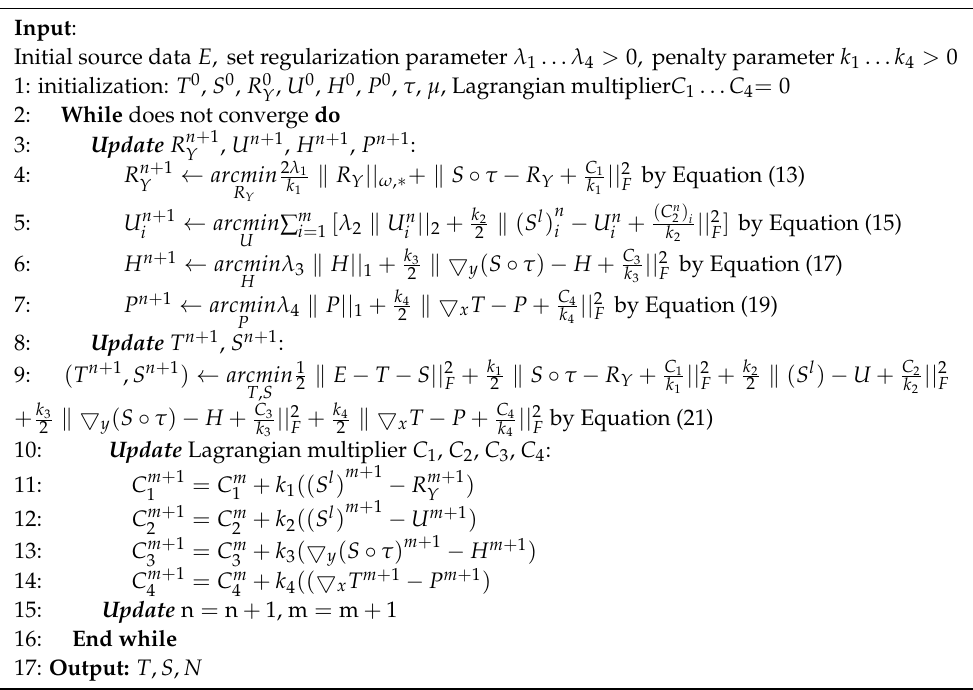
Algorithm 1 ADMM-based error